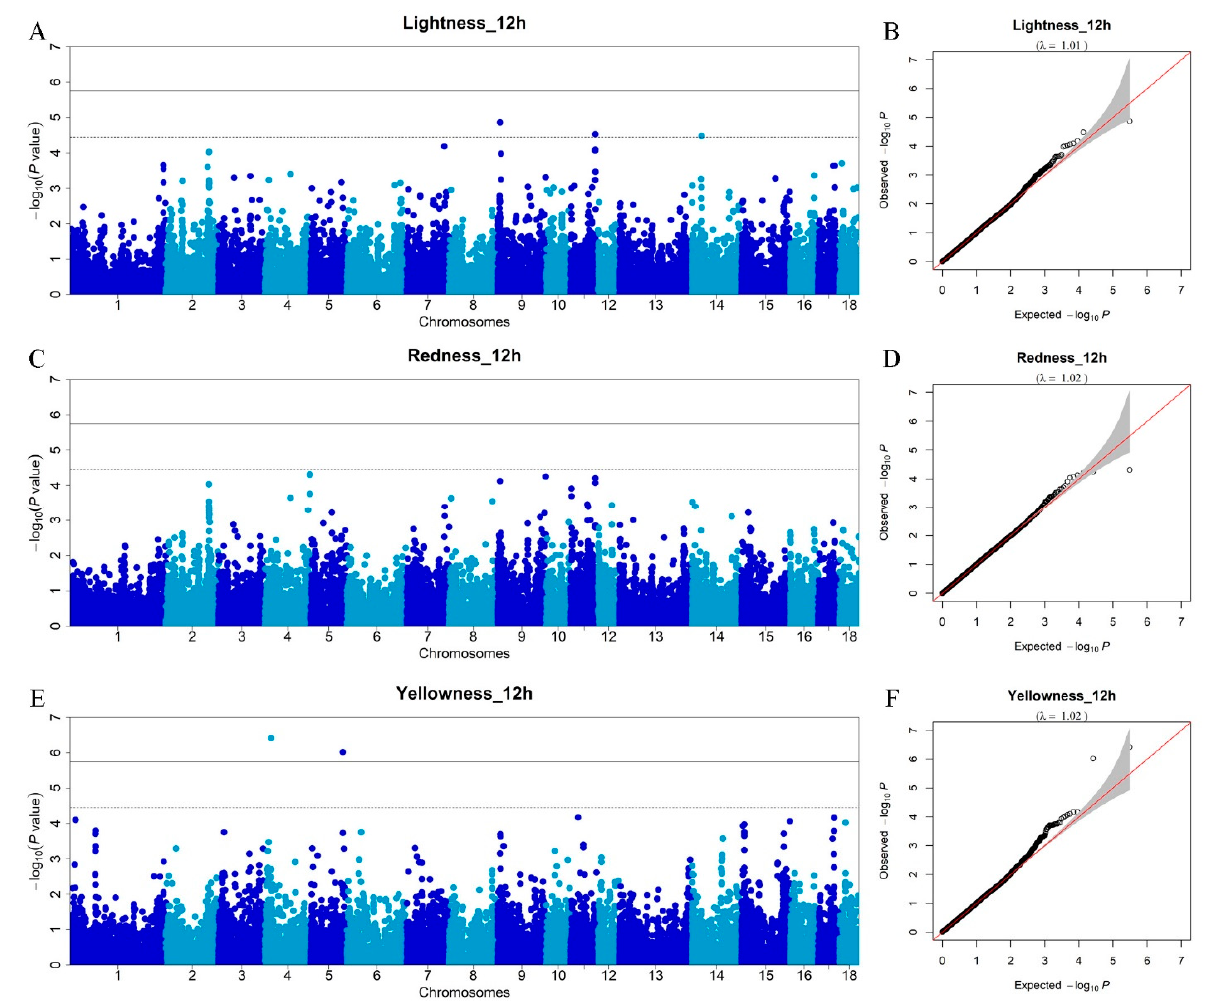
Figure 4. Manhattan plots of the GWAS and Q–Q plots for meat color traits (12 h). ( A ) GWAS for L* _12h (lightness_12h); ( B ) Q–Q plot for L* _12h (lightness_12h); ( C ) GWAS for a* _12h (redness_12h); ( D ) Q–Q plot for a* _12h (redness_12h; ( E ) GWAS for b* _12h (yellowness_12h); ( F ) Q–Q plot for b* _12h (yellowness_12h). The x -axis represents the chromosomes, and the y -axis represents the -log10 ( p -value). Table 2. Significant SNPs associated with meat quality traits (45 min) in DLY